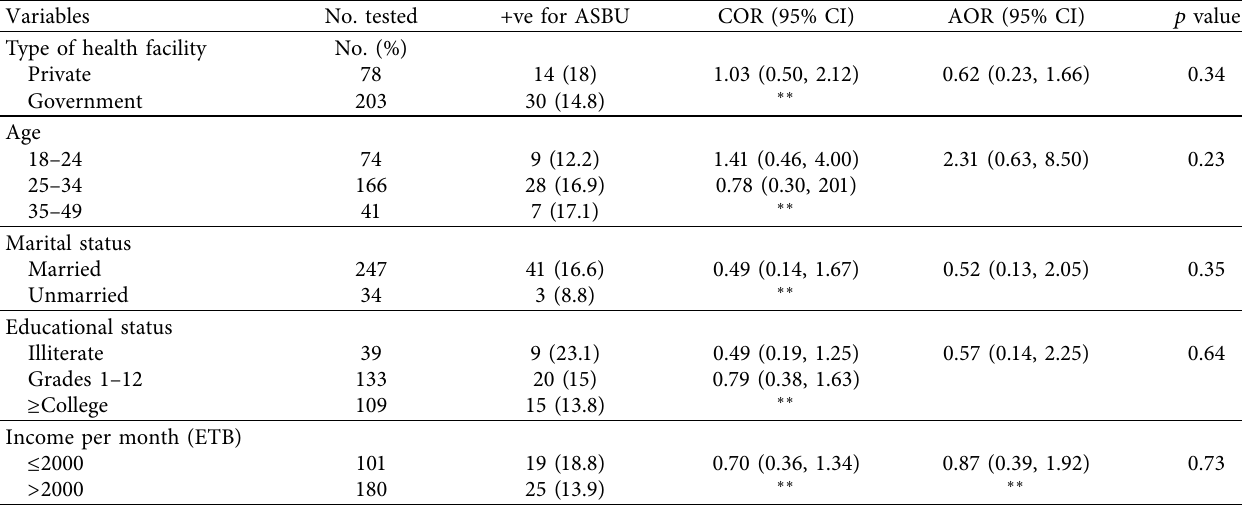
Table 1: Association of demographic characteristics with ASBU in pregnant women attending antenatal care services in Addis Ababa, Ethiopia ( N